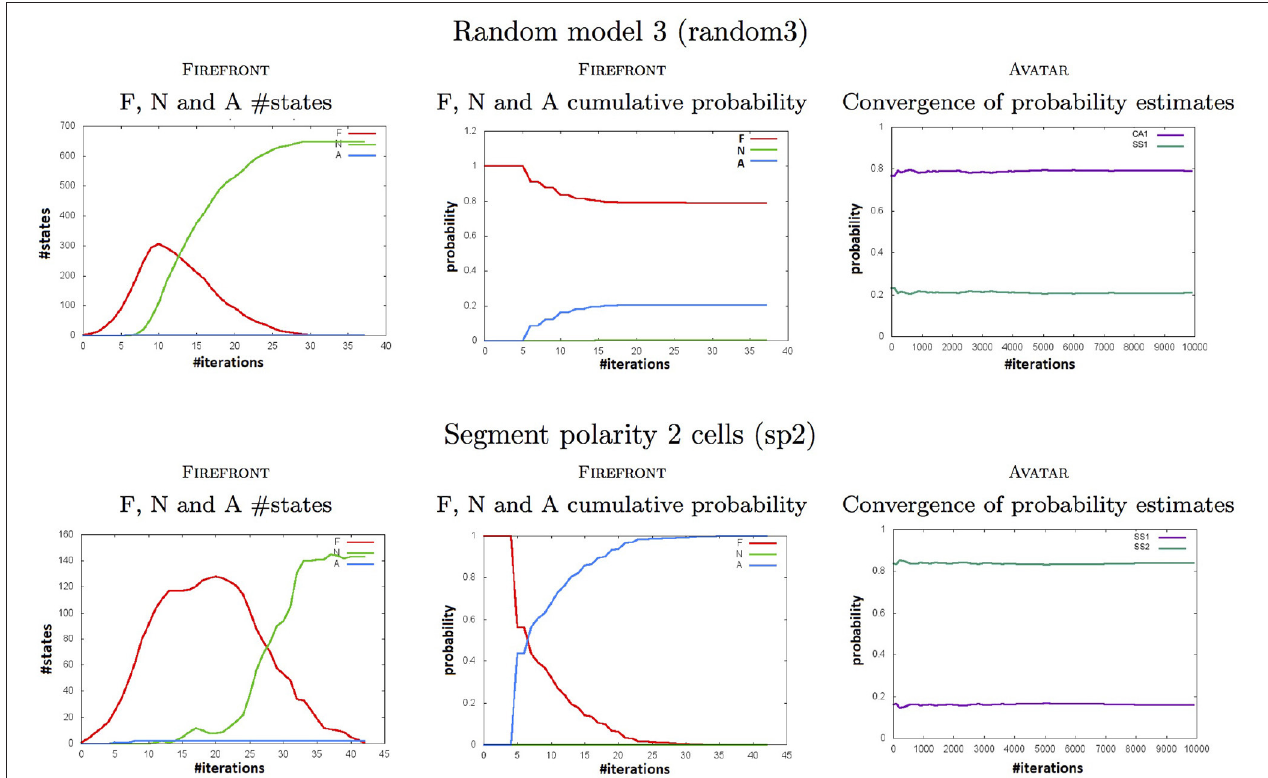
FIGURE 4 | Plots computed by FIREFRONT and AVATAR throughout simulations for the random3 (Top) and the sp1 (Bottom) models (see Tables 1 , 2 ). Left plots show the numbers of states to be expanded (in F ), of neglected states (in N ), and of attractors (in A ). Middle plots show the cumulative probabilities of the 3 sets. Right plots show the convergence of the reachability probability of each attractor.